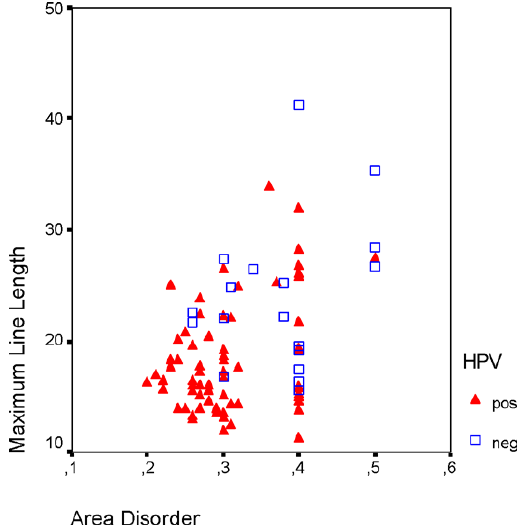
Fig. 4. Scatterplot of the maximum MST line length and the area disorder for the high-risk human papillomavirus (HPV) positive and negative cases. The variables chosen were the two most discriminat- ing ones in the multivariate stepwise regression analysis. DNA. However, there was considerable overlap for the different grades. One explanation could be that pathol- ogists diagnoses are not well reproducible [14], but although the discrimination of the expert’s consensus grades was better there was also considerable